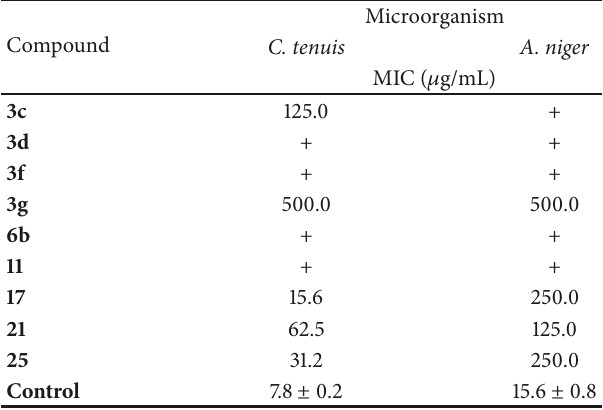
Table 4: Antifungal activity of the compounds determined by serial dilution method.